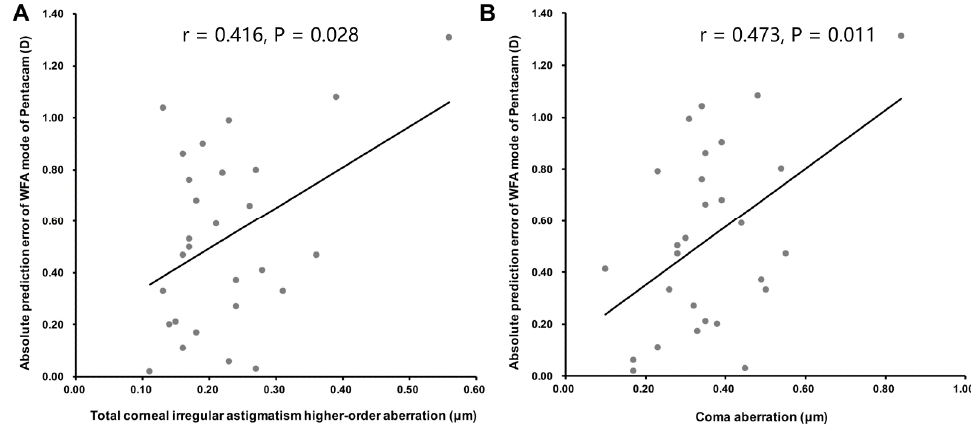
Figure 5. Correlations between the absolute prediction error determined using the WFA mode and corneal asymmetry. The absolute prediction error of the WFA mode was positively correlated with the total corneal irregular astigmatism higher-order aberration ( A ; Pearson’s r = 0.416, p = 0.028) and with the coma aberration ( B ; Pearson’s r = 0.473, p = 0.011).